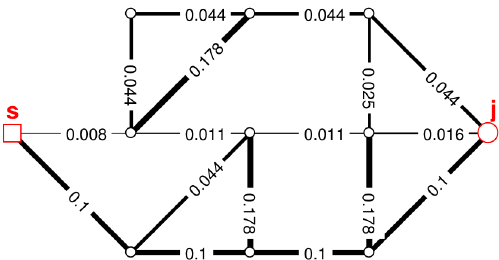
Figure 4. Network represented as weighted graph with edge weights w i = L i /D 2 . i